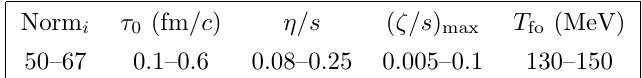
Table 1 . Ranges for independently varied model